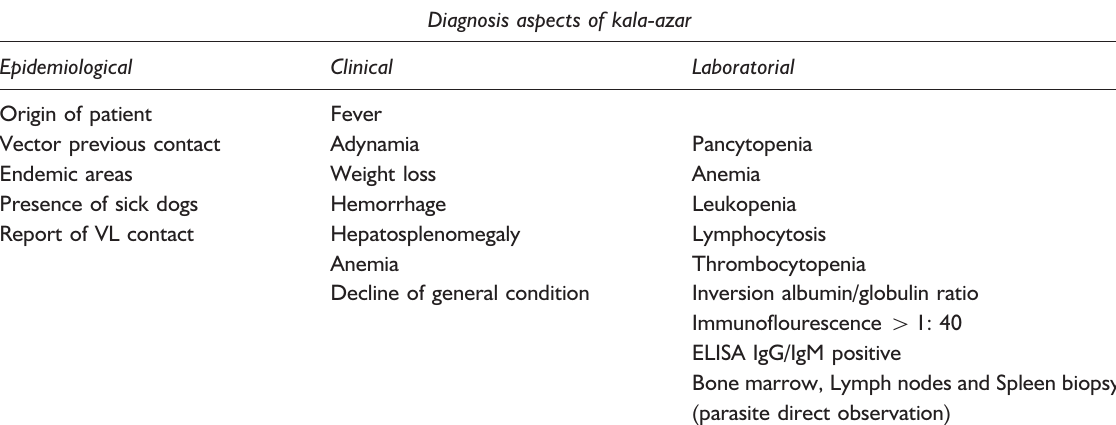
Table 3 Most common diagnosis aspects of visceral leishmaniasis during pregnancy